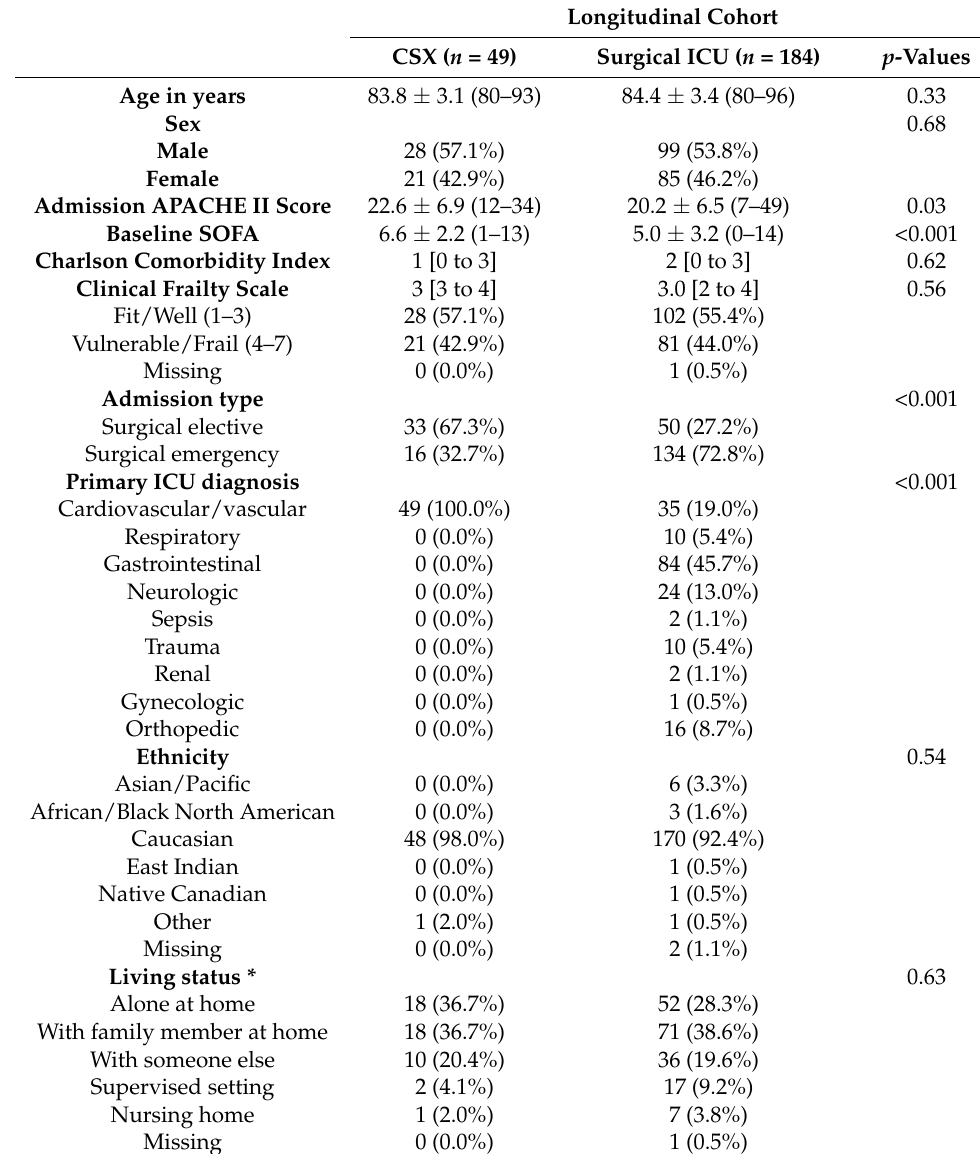
Table 1. Baseline characteristics, continuous variables are reported as mean ± standard deviation (minimum–maximum) or median (Q1 to Q3), categorical variables are reported as count (%); Abbre- viations: CSX: Cardiac Surgery, SOFA = Sequential Organ Failure Assessment, APACHE = Acute Physiology and Chronic Health Evaluation II, ICU = Intensive Care Unit, * Residential living status prior to hospital